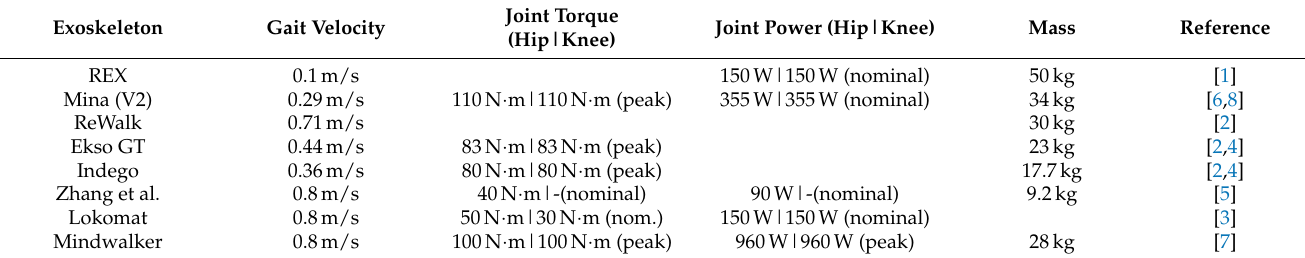
Table 1. Active exoskeletons for the lower extremity for paraplegic patients.